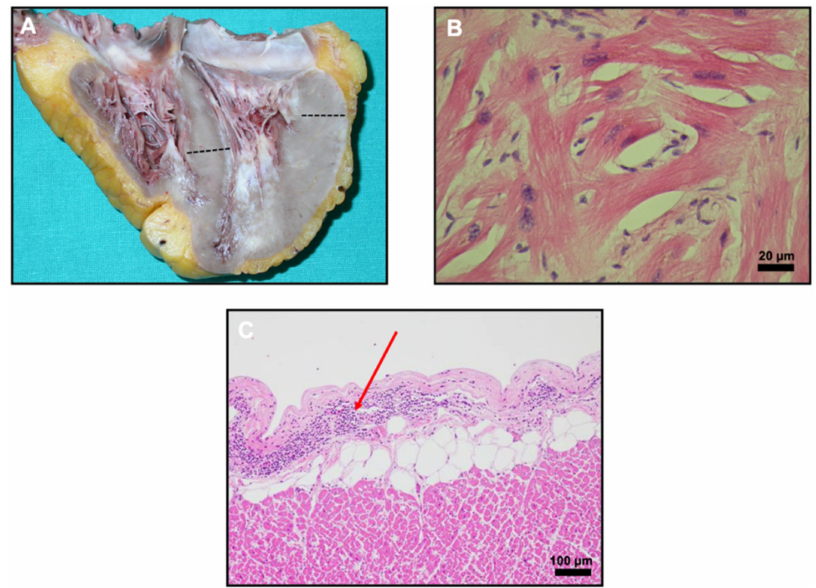
Figure 1. ( A ) Two chambers view of the proband’s heart. The increased thickness of the left lateral ventricle wall (2.0 cm) and the inter ventricular septum (1.8 cm) is evidenced by black dotted lines. ( B ) Hematoxylin-eosin staining of the myocardium shows cardiomyocytes disarray which is often seen in hypertrophic cardiomyopathy (HCM). ( C ) Epicardium exhibits a focus with lymphocytic infiltrate (dark purple dots; red arrow) indicative of lymphocytic